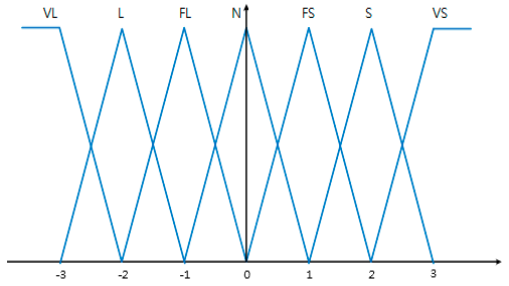
Figure 3. Membership function.